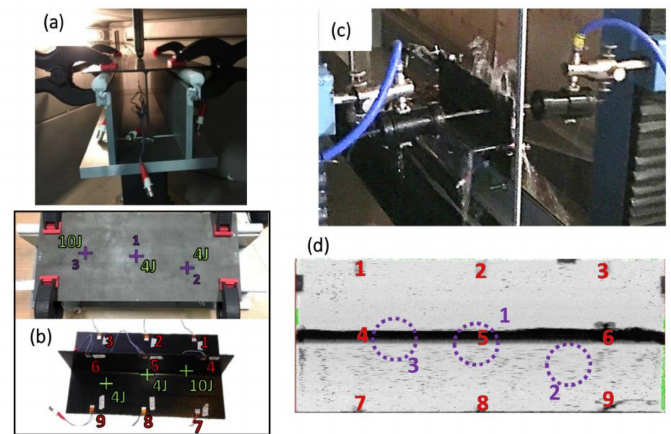
Figure 5. ( a ) Impact testing configuration with the impactor and the T-joint fixed on its support in the chamber of the impact tower; ( b ) Locations of the three impacts: first impact of 4J in the middle, second impact of 4J and third impact of 10J; ( c ) Water jet probe inspection system; ( d ) C-scan of the T-joint after three impacts, with locations of impact (in purple) and of PZTs (in